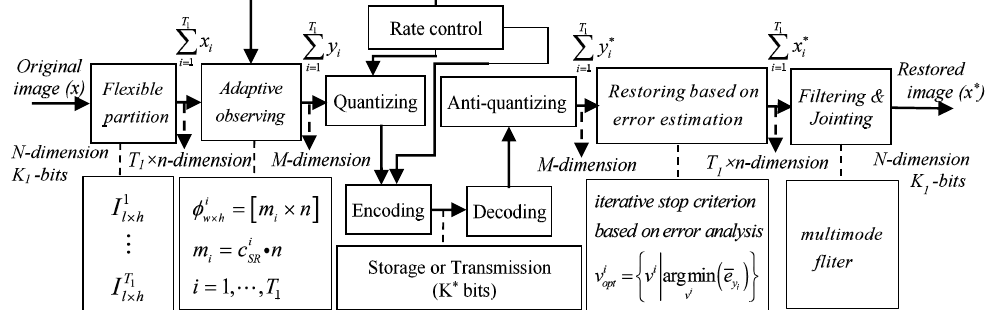
Figure 10. The workflow of the FE-ABCS-QC algorithm.